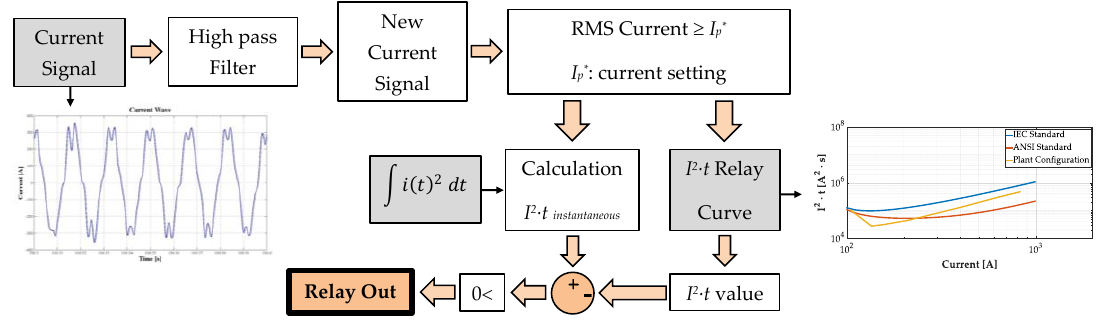
Figure 8. Proposed overcurrent relay 50/51 model.